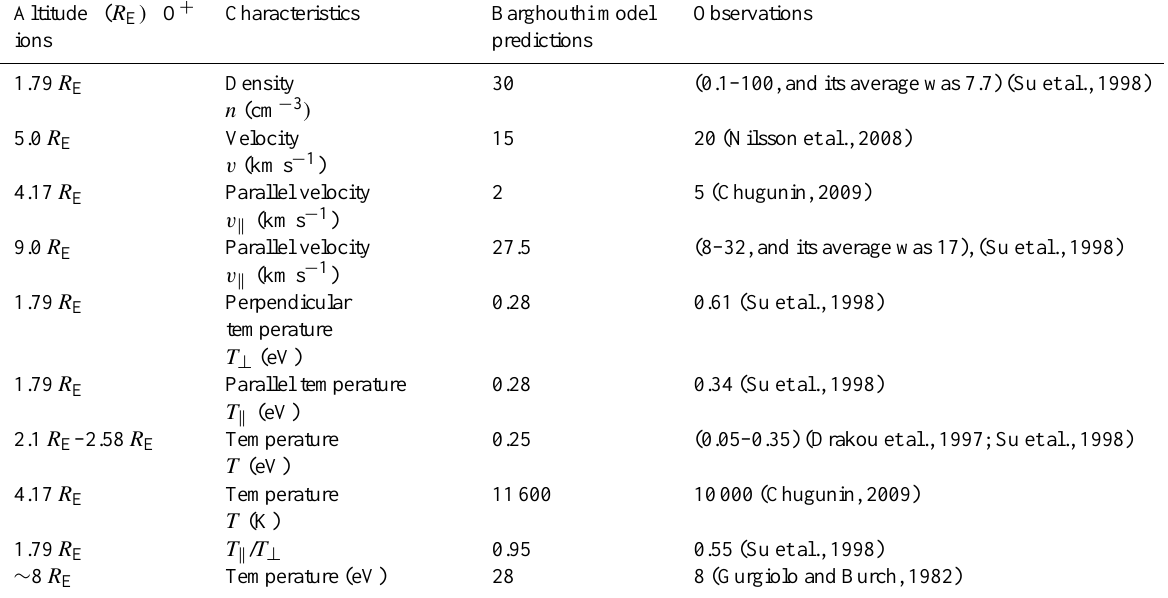
Table 2. Comparison between the observations and simulation results of Barghouthi model for O + ions. Please note, in observational studies they use the terms velocity, parallel velocity, and drift velocity. All these terms are the same in observational studies and correspond to drift velocity in simulation